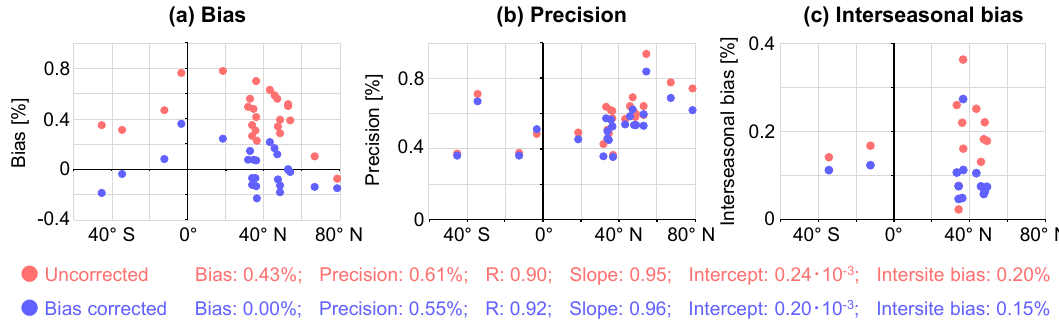
Figure 9. Latitudinal plot of ( a ) the bias, ( b ) precision, and ( c ) interseasonal bias of the uncorrected and the bias-corrected GOSAT ratio component for each TCCON site. Only sites having more than nine data points are shown. The bias, precision, correlation coefficient (R), and the slope and intercept of the linear regression calculated using all data (in a manner similar to Figure 1a) are presented below the graphs.